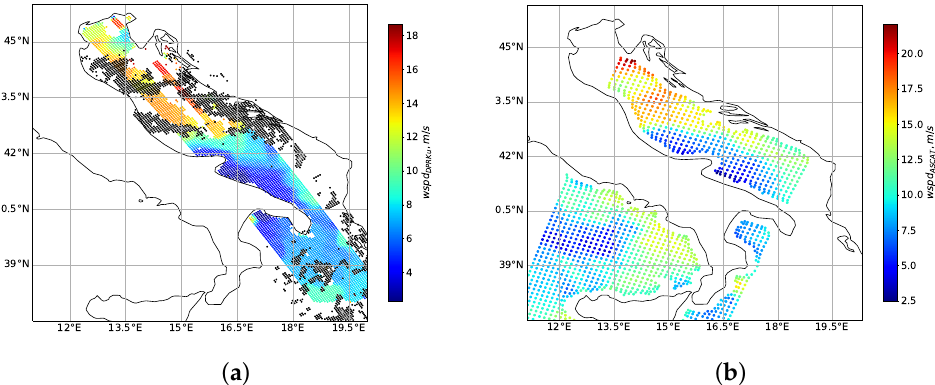
Figure 10. ( a ) Wind speed in the Adriatic sea on 17 January 2017, 06:20 UTC, according to Ku-band DPR data (color), rain contaminates cells with rain rate over 0.5 mm/h (black); ( b ) wind speed in the Adriatic sea on 17 January 2017, 08:50 UTC, according to ASCAT